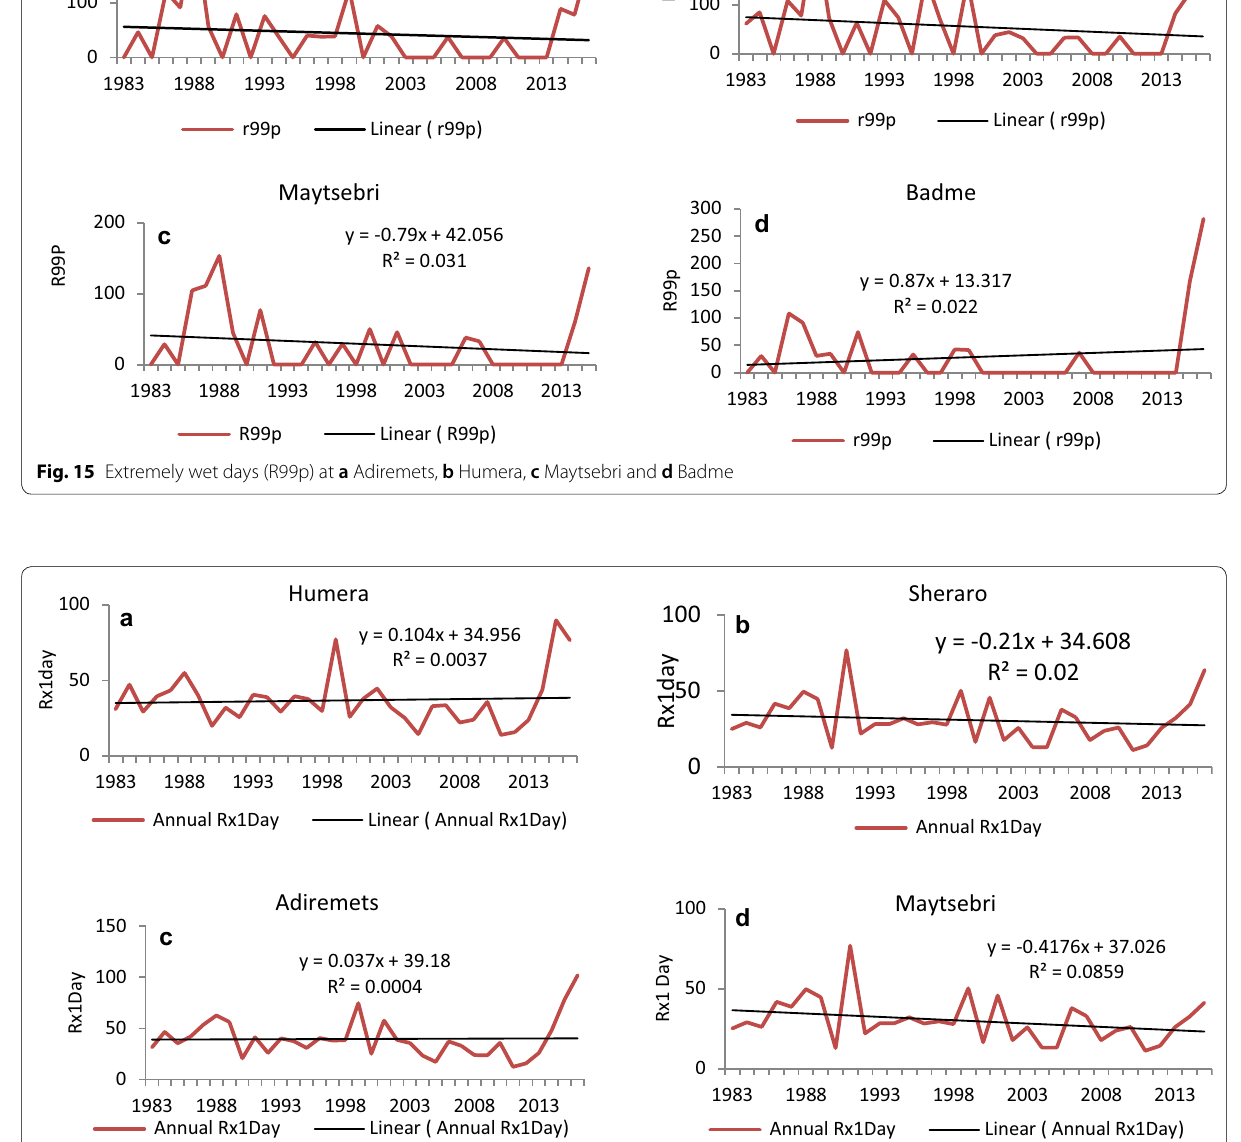
Fig. 16 Annual maximum one-day rainfall (Rx1Day) at a Humera, b Sheraro, c Adiremets, d